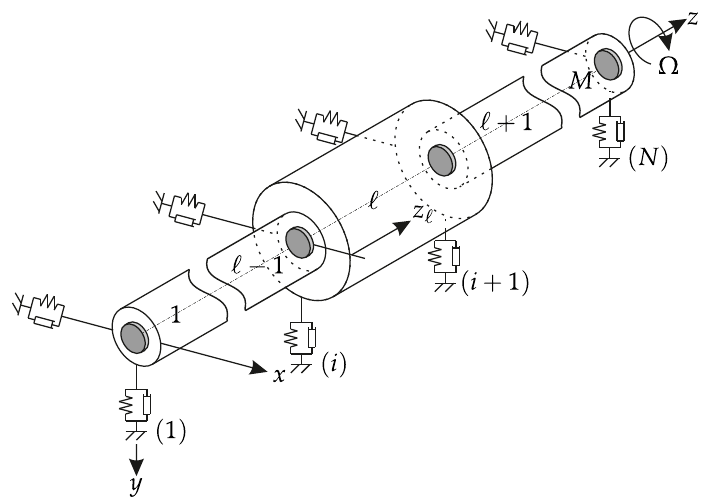
Figure 1. General rotor